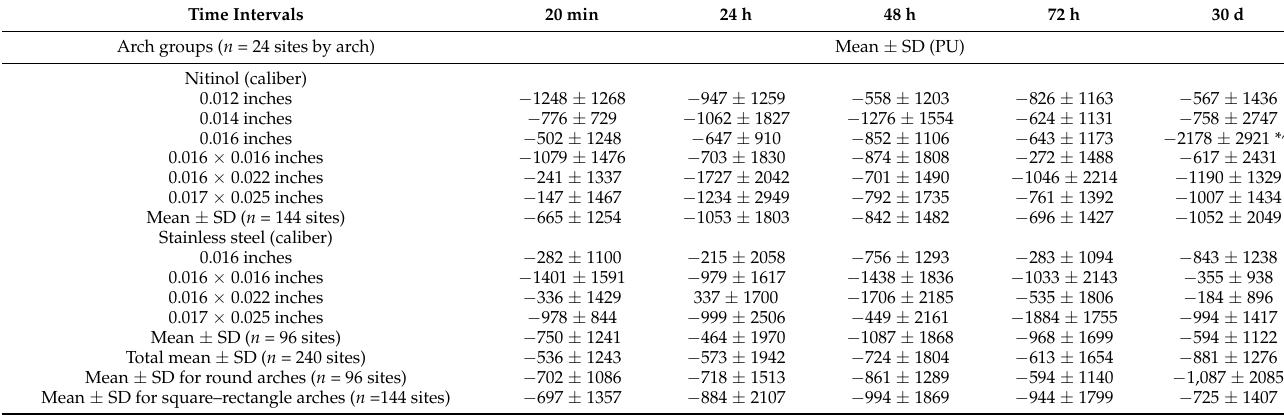
Table 3. Difference between integration (DBI) in patients with orthodontic treatment (Nitinol and stainless steel arches) at different time